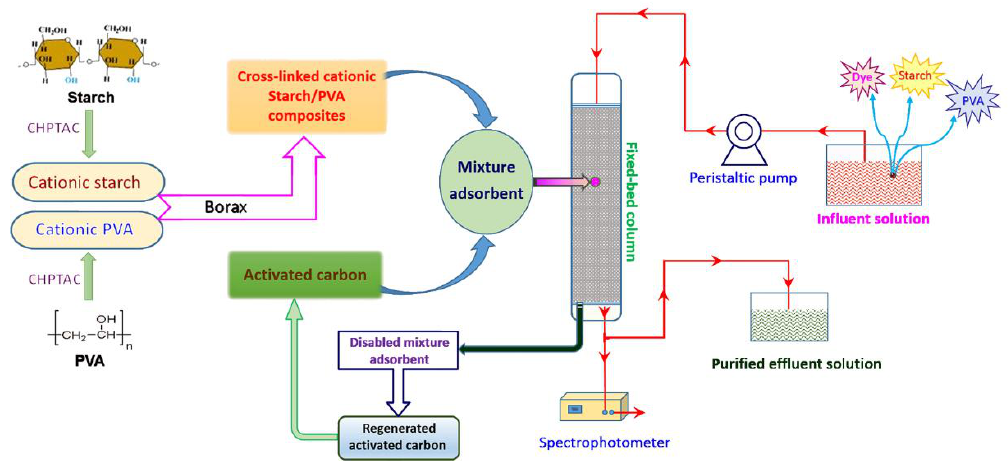
Figure 2. Schematic representation of the adsorption-recycle process. PVA—polyvinyl alcohol; CHPTAC—3-chloro-2-hydroxypropyltrimethylammonium chloride.